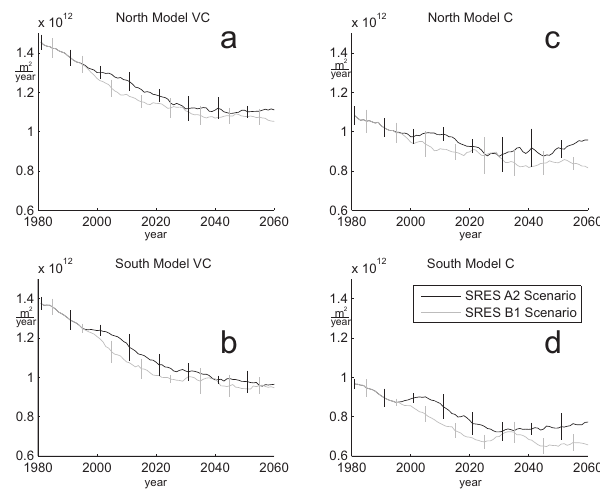
Fig. 9. Projected burned area of the Northern (a and c) and South- ern (b and d) Hemisphere of Africa using model VC (a and b) and model C (c and d) for the two SRES storylines A2 and B1 from 1980–2060. The time period from 1980–2000 is derived from the control simulation of the 20th century. Lines are 10-year moving averages and bars show the standard deviation within the 10